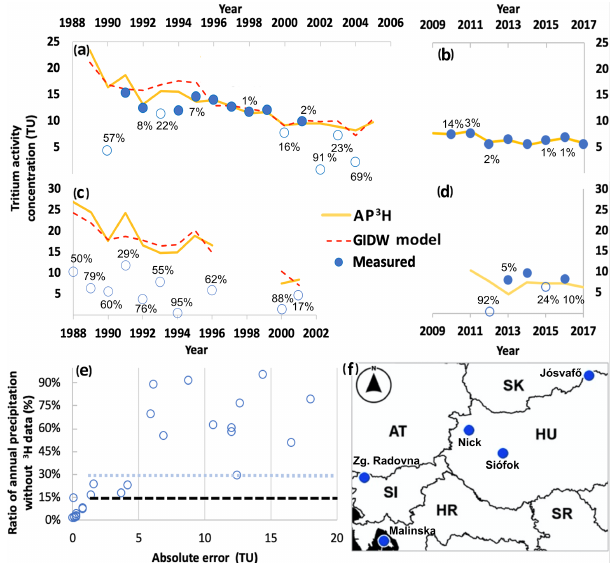
Figure 5. Amount-weighted annual mean 3 H activity concentration in precipitation measured at (a) Nick (1990–2004; HU), (b) Zgornja Radovna (2010–2017; SI), (c) Jósvaf˝o (HU; 1988–1996) and Malin- ska (2000–2001; Krk Island; HR), and (d) Siófok (2009–2017; HU) stations along with the corresponding AP 3 H estimates. The percent- ages next to the symbols of the measured values indicate the ratio of fallen precipitation not analyzed for 3 H in a given year if it was > 0%. The dashed red line in panels (a) and (c) shows the corre- sponding values of global inverse distance weighted model (GIDW; Jasechko and Taylor, 2015). (e) Cross plot showing the relationship between absolute error of estimated precipitation 3 H activity by the AP 3 H and the percentage of precipitation without 3 H measurement at Nick, Zgornja Radovna, Jósvaf˝o, and Malinska. The thick dashed line marks the limit of completeness (15%) applied in this study, while the gray dotted line marks the limit of completeness (30%) according to the GNIP protocol (IAEA, 1992). (f) The map shows the location of the five sites used for evaluation of the performance of the AP 3 H